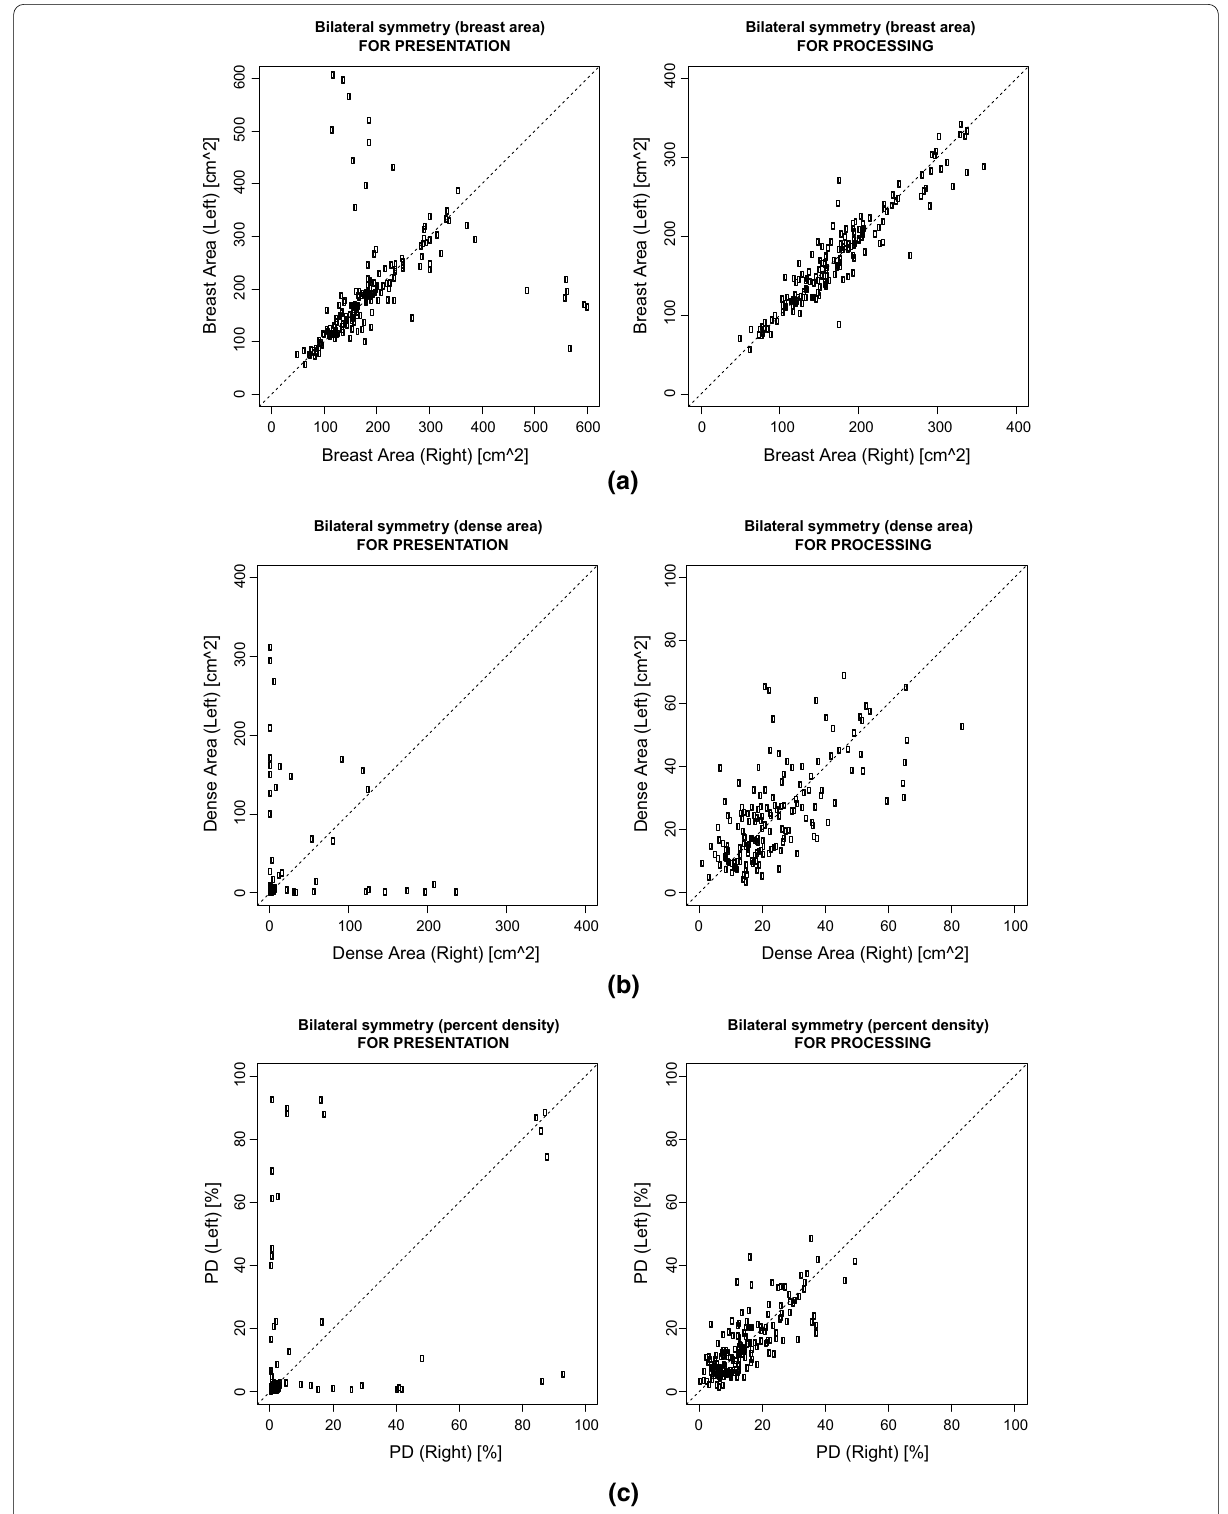
Fig. 3 Bilateral simmetry with respect to breast-area ( a ), dense-area ( b ) and percent-density ( c ). Each circle is a woman. Women with strong bilateral simmetry should be aligned with the identity line